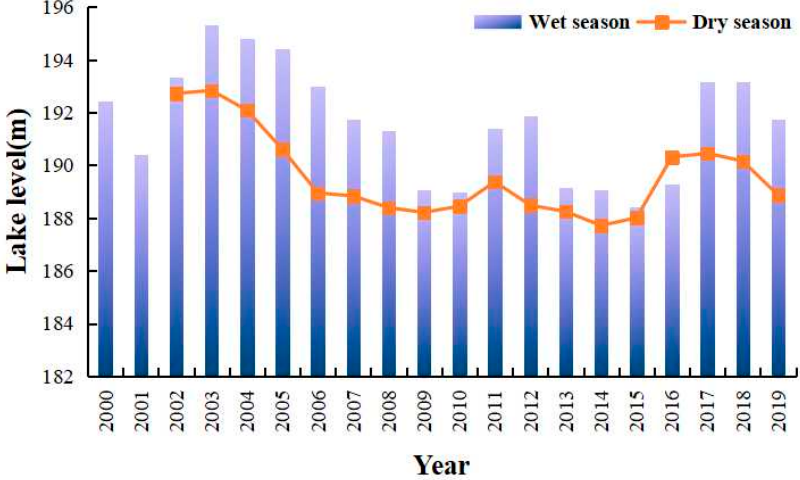
Figure 11. Lake water level changes from 2000 to 2019.